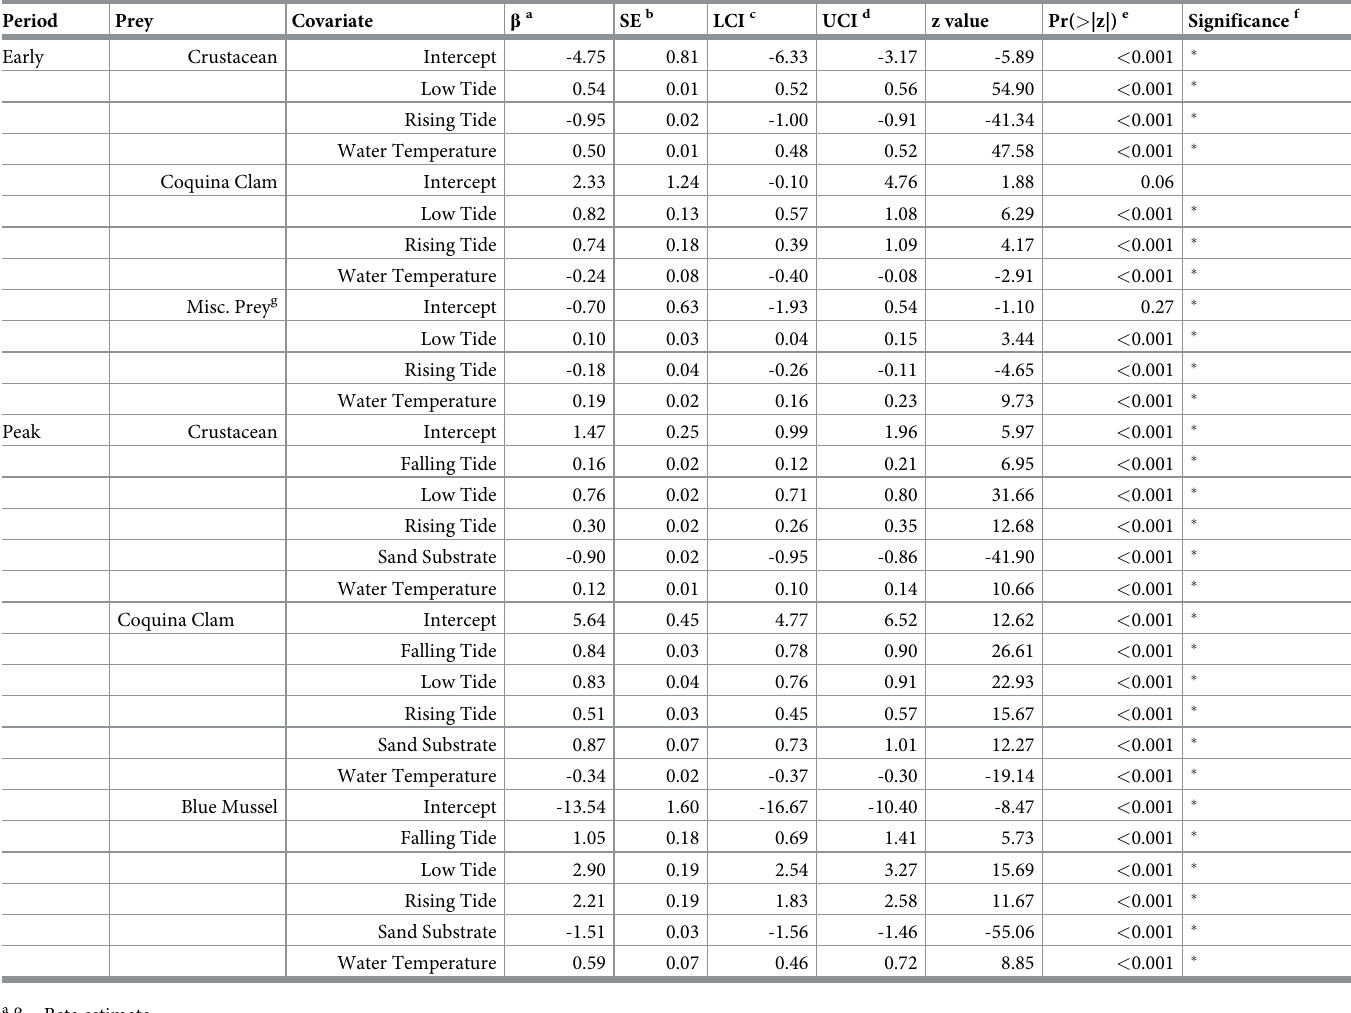
Table 4. Parameter estimates ( β ) from the most parsimonious generalized linear mixed effects regression models predicting crustacean, coquina clam, and miscel- laneous prey abundances (organisms/m 2 ) captured in 10 cm diameter x 3.5 cm deep cores on peat substrate early in red knot migration (May 14–20, 2008–2018, except 2010; n = 457; ‘early’), and on sand and peat substrates near the peak of red knot migration (May 21–27, 2007–2018; n = 1,322; ‘peak’), Virginia’s barrier islands. All models contained “Island” and “Year” as random effects. Period Prey